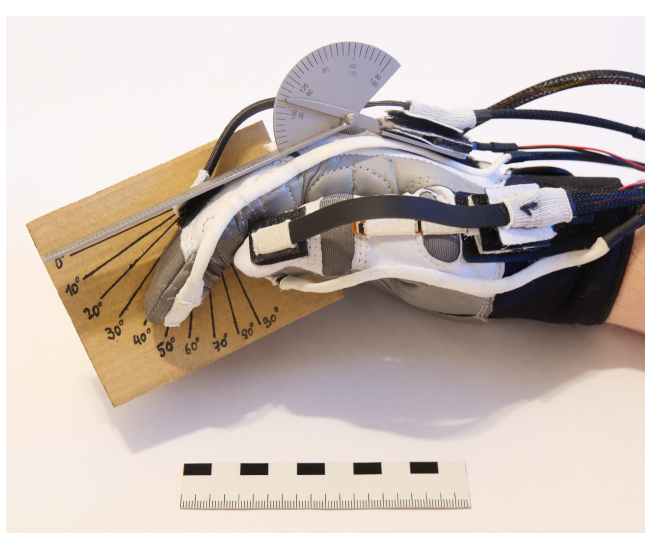
Figure A3. Validation setup for SenGlove. Using an analog finger goniometer, the target angles θ MCP , set and θ PIP , set were set at the Metacarpophalangeal (MCP) and Proximal Interphalangeal (PIP) joint of the finger and kept constant during a series of measurements. In this figure, a measurement for finger II with θ MCP , set = 40°, θ PIP , set = 30° is shown. Compliance with these angles was checked using the finger goniometer and an angle template. After completion of the validation measurement, the angle of the Distal Interphalangeal (DIP) joint was measured with the finger goniometer, which was set due to the coupling to the PIP